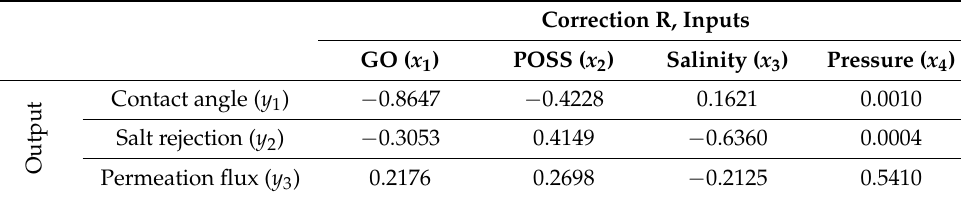
Table 4. Correlation R between the input and output components.